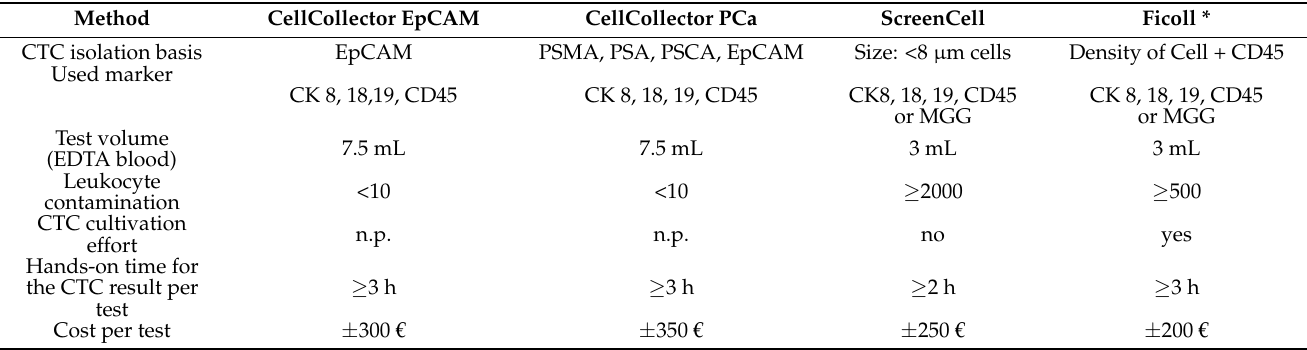
Table 3. Characteristics of different CTC isolation